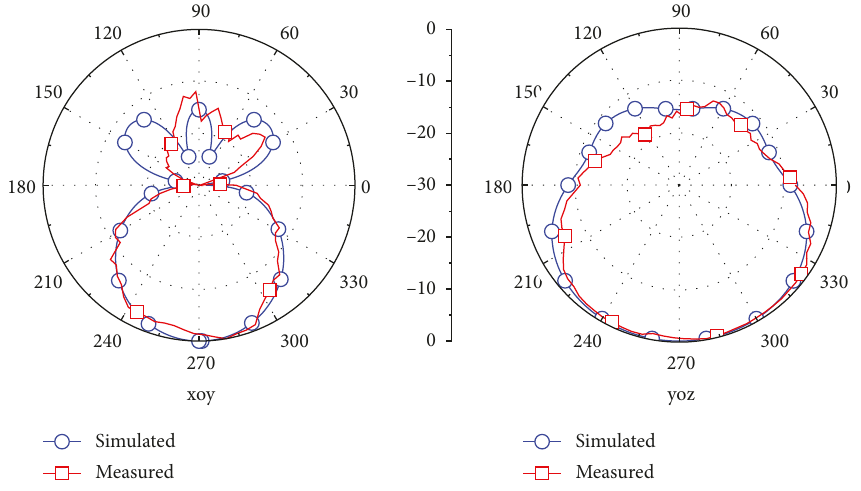
Figure 13: Simulated and measured radiation patterns at